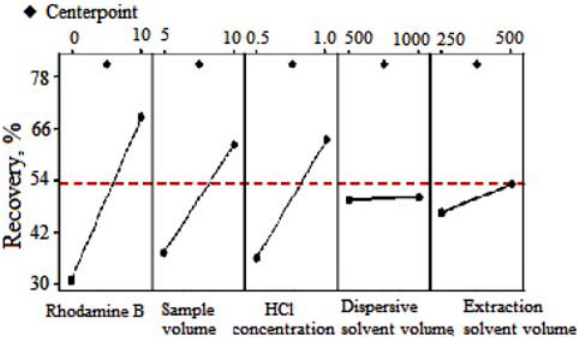
Figure 1. Main effects plot for recovery of gold